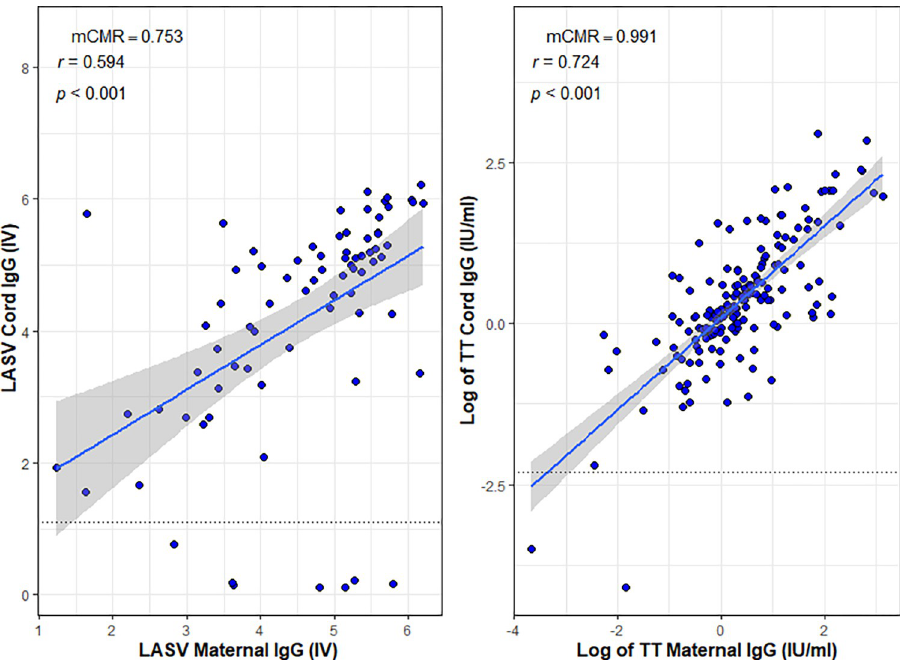
Fig 1. Correlation between maternal and cord Lassa and TT IgG antibodies assessed by Spearman’s correlation (r). Note: IV- index value; mCMR- median cord maternal ratio; black dotted horizontal line is line of seropositivity (LASV = 1.1, TT = 0.1IU/mL); blue line is the regression line; grey shaded are the 95% confidence interval fitted to the regression line.